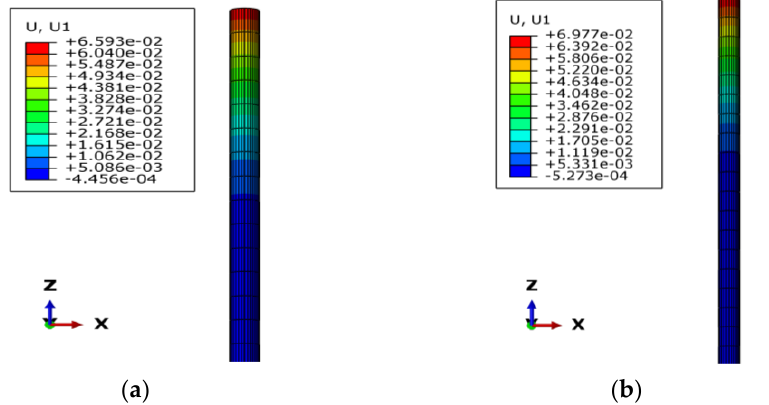
Figure 8. Simulation results of the lateral deformation, where ( a ) is the result calculated by the contact surface model and ( b ) is that calculated by the Goodman contact element model.